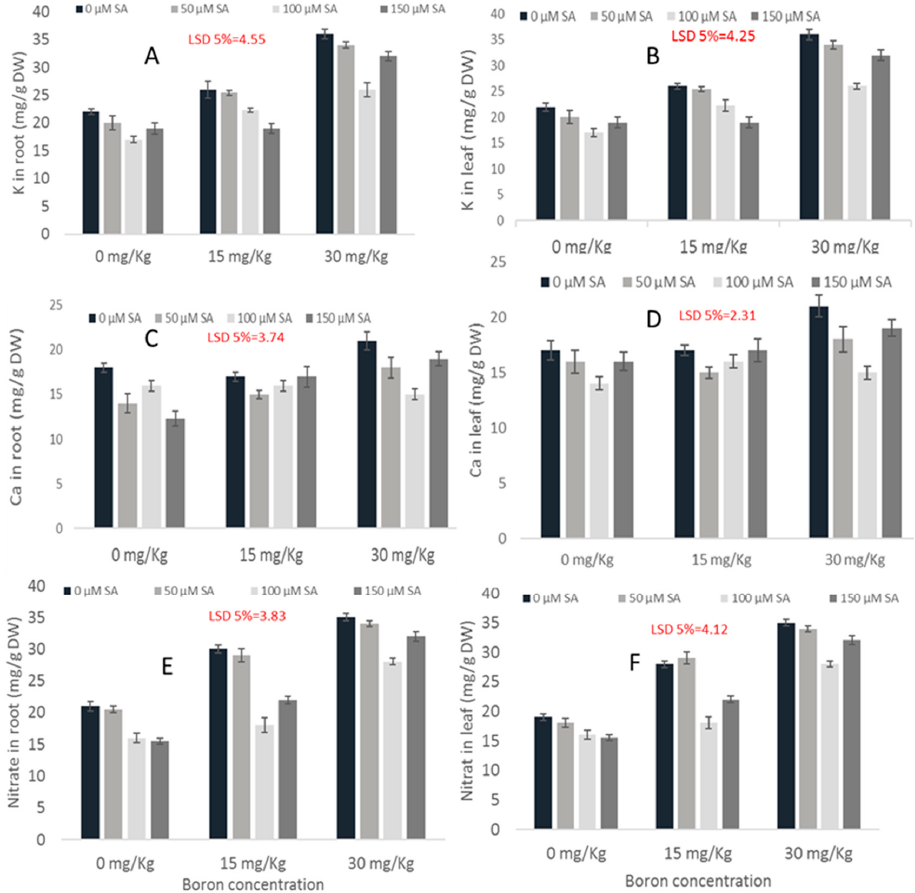
Figure 4. Effect of SA on the K ( A , B ), Ca ( C , D ) and nitrate ( E , F ) contents in the roots and leaves of maize cultivar Gohar-19 under varying B toxicity levels . Table 3. Effect of SA (0, 50, 100 and 150 µM) on the leaf ascorbic acid, H 2 O 2 , proline and glycine betaine